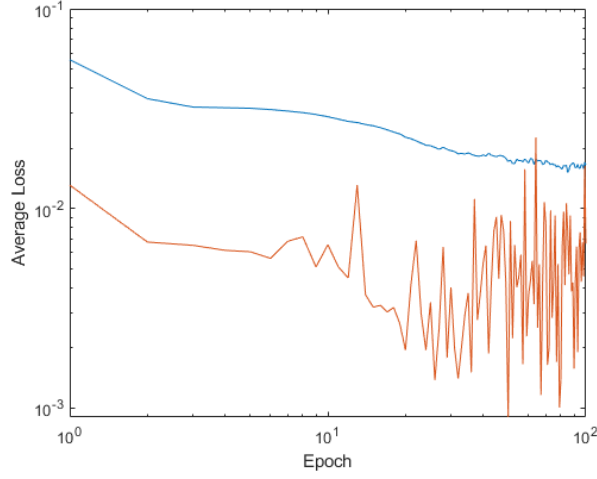
Figure 18. Average loss on training patterns in blue and validation patterns in orange for Standard SGD of Cross-in-Tray function.